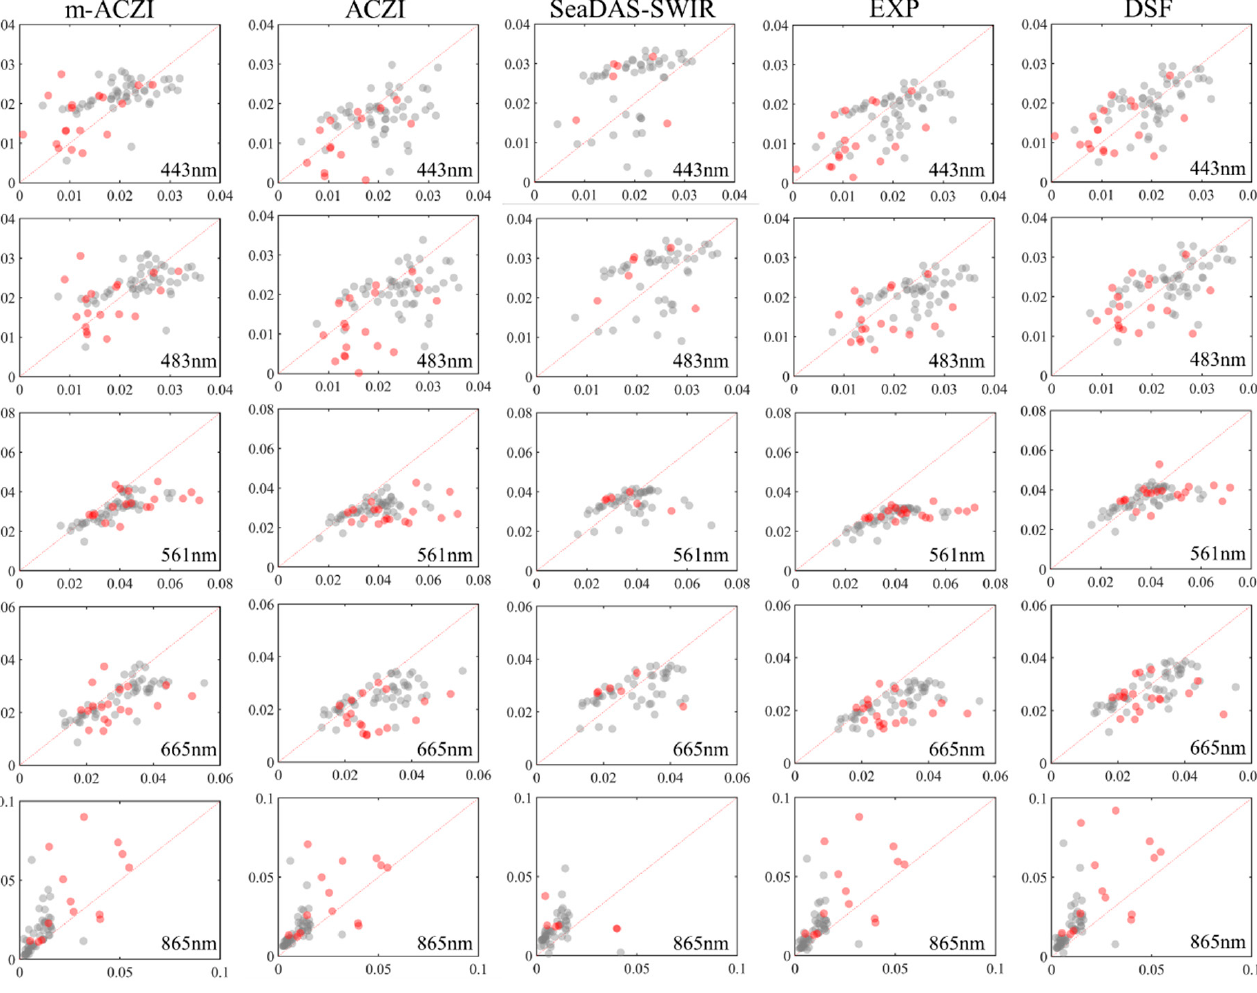
Figure 11. Sca tt erplots of AC-driven R rs of di ff erent water types versus in situ R rs . The red points Figure 11. Scatterplots of AC-driven R rs of different water types versus in situ R rs . The red points represent water with fl oating blooms, and the gray points represent un- fl oating blooms. represent water with floating blooms, and the gray points represent un-floating blooms. Table 3. Statistics of the accuracy measures for atmospheric correction algorithms for un-floating blooms using in situ R rs measurements. The BLUE number represents the minimal statistical